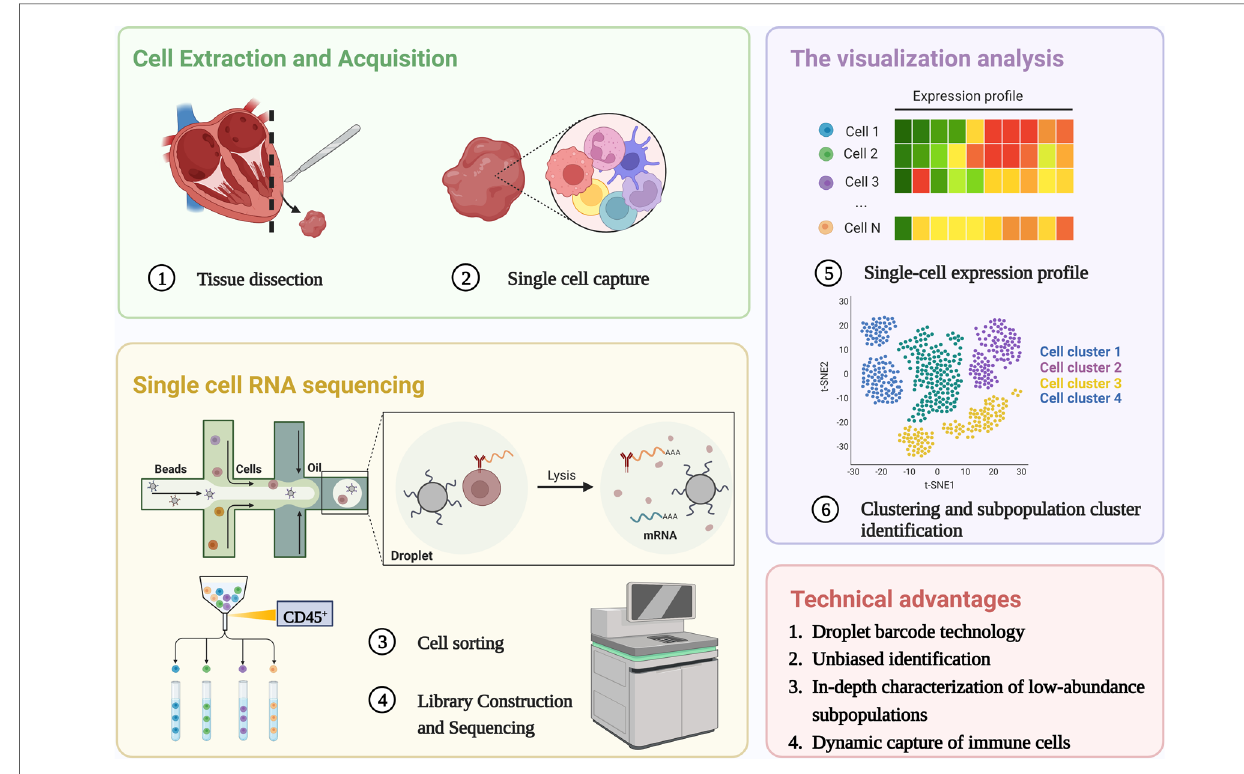
FIGURE 1 Single cell RNA sequencing work fl ow. The process shared by scRNA-Seq: single-cell isolation and capture, cell lysis, reverse transcription and ampli fi cation, library preparation, sequencing, and analysis. The unique advantages of scRNA seq in the study of immune heterogeneity: Application of barcode technology, unbiased identi fi cation and in-depth characterization of low abundance subpopulations, Dynamic capture of immune cells without ignoring transitional cell events. Created with